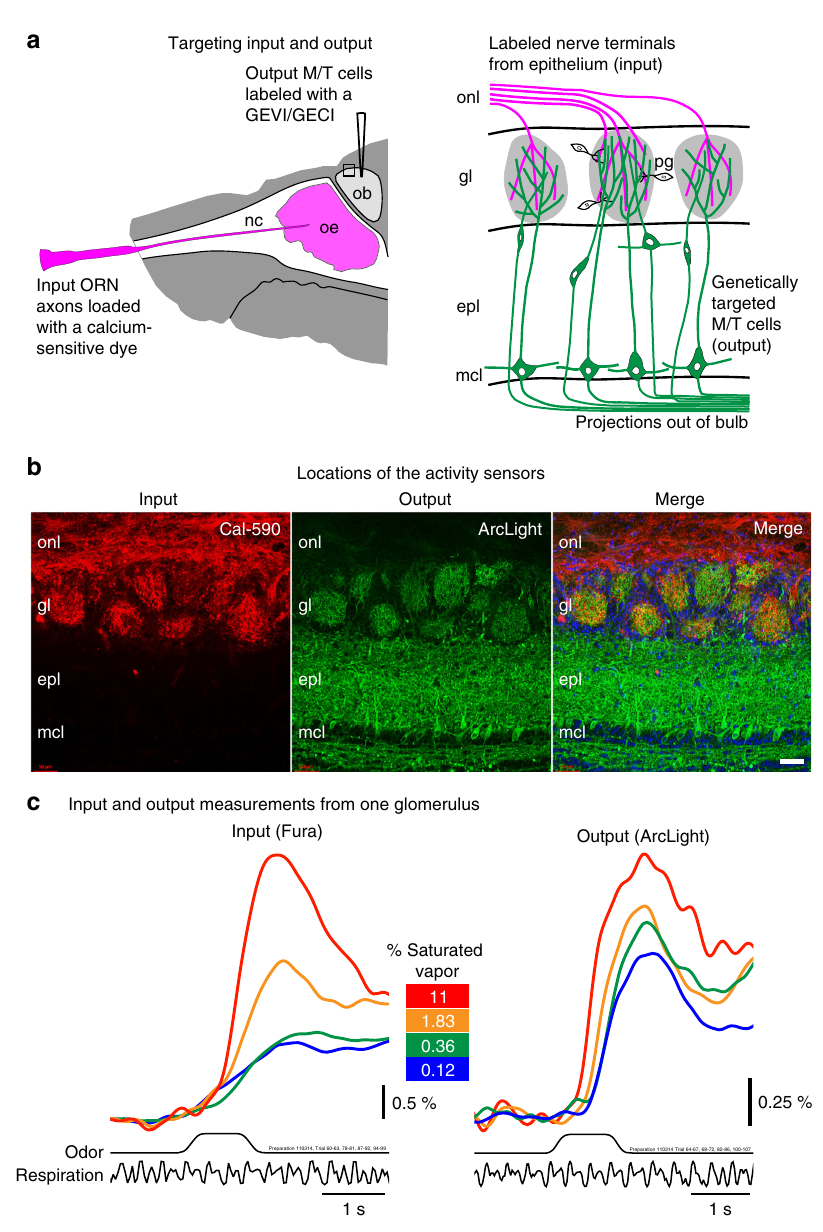
Fig. 1 Cell speci fi c targeting of activity sensors to the olfactory receptor neuron input and the mitral/tufted cell output, and optical measurements from one glomerulus. a Experimental approach: ( left ) Olfactory receptor neuron nerve terminal input was labeled via a nasal infusion of a calcium sensitive dextran dye. Cre recombinase expressing mitral and tufted cell output was targeted using cre-dependent viral vectors that expressed genetically encoded voltage or calcium indicators (GEVI or GECI). ( right ) By using activity sensors with substantially different excitation or emission spectra, input vs. output can be measured independently from the same glomerulus by changing the excitation or emission wavelengths. b A histological section shows anatomical targeting of Cal-590 dextran to the olfactory receptor nerve terminal input in the glomeruli ( left ) and genetic targeting of ArcLight to the mitral and tufted cell output ( middle ) in the same section along with a merged image containing DAPI ( right ). c Optical measurements from input and output sensors in one glomerulus in response to ethyl tiglate presented across ~2 log units of odorant concentration (0.12 – 11% of saturated vapor). Input and output measurements were performed sequentially using Fura dextran and ArcLight, using excitation wavelengths of 380 nm and 480 nm, respectively. The optical traces are low-pass fi ltered at 1 Hz and are the average of 3 – 7 individual trials aligned to the fi rst sniff following odor onset. The odor and respiration traces are from one of the single trials. The data in b and c are from different preparations. onl, olfactory nerve layer; gl, glomerular layer; epl, external plexiform layer; mcl, mitral cell layer, ORN, olfactory receptor neuron; M/T, mitral and tufted cells. Scale bar in b, 50 µ m. Details for the data in panel c